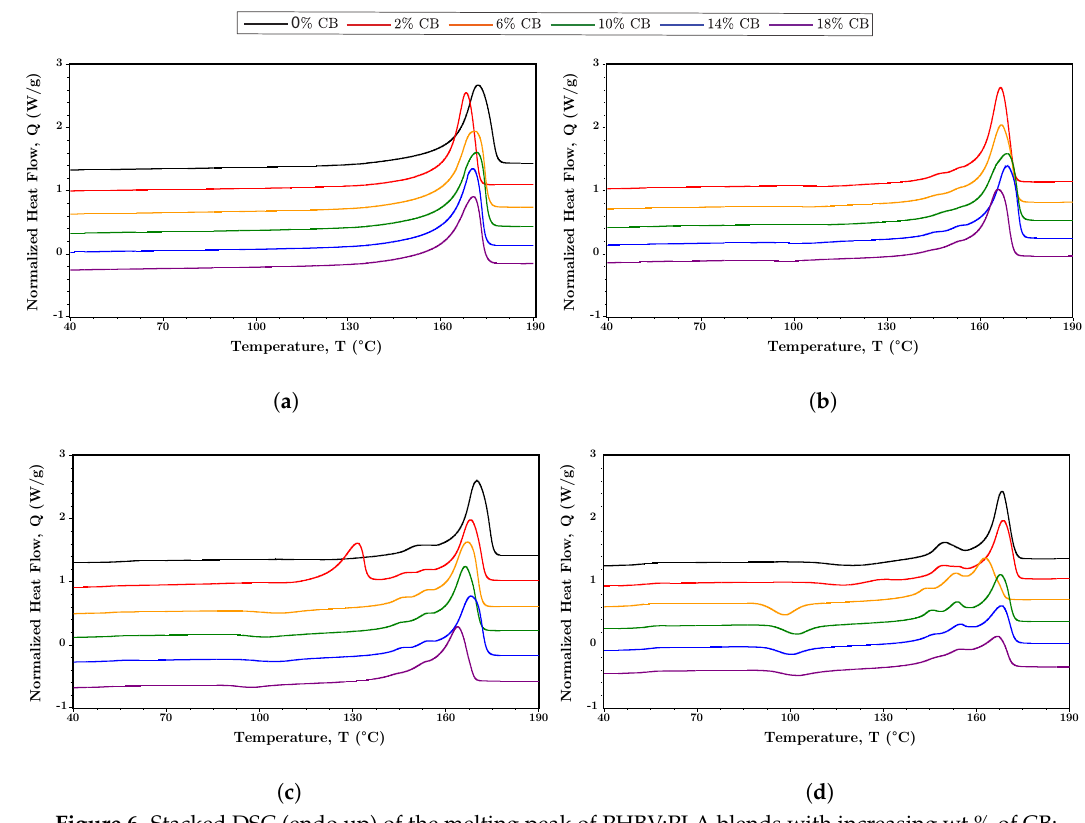
Figure 6. Stacked DSC (endo up) of the melting peak of PHBV:PLA blends with increasing wt.% of CB: ( a ) PHBV:PLA = 100:0, ( b ) PHBV:PLA = 90:10, ( c ) PHBV:PLA = 80:20, and ( d ) PHBV:PLA =